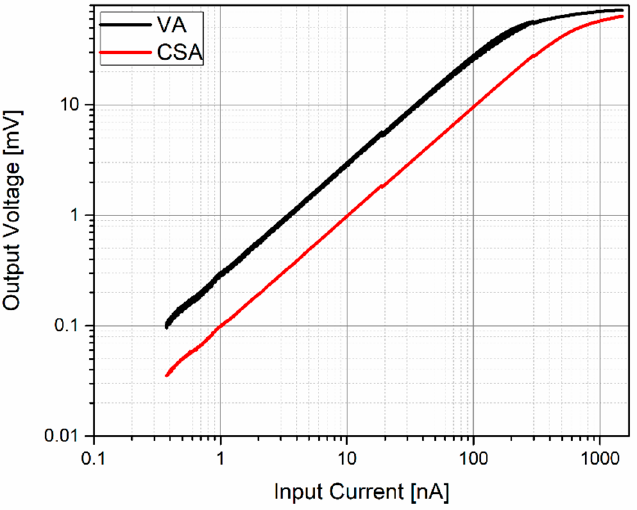
Figure 16. Dynamic range measurements: the VA amplifier (black) and the CSA amplifier (red).